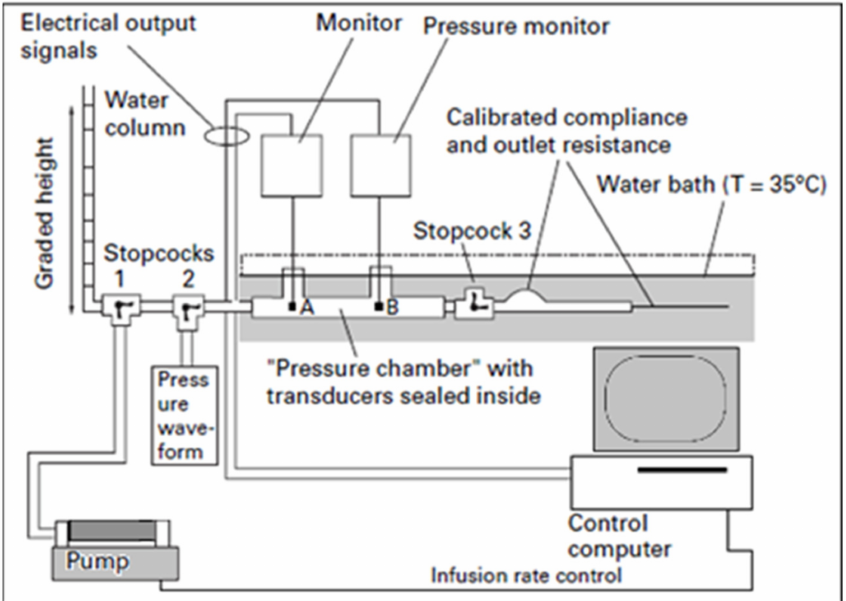
Figure 5. Bench Test Procedure: A bottle is filled with deionised water, leaving 20 mL of air to be removed during dynamic catheter testing. The bottle is then submerged horizontally in a water bath at a constant temperature of 35 ◦ C. Static pressure on the bottle (representing pressure detected by ICP catheters) and reference static pressure (representing true ventricular pressure) are compared by changing the height of a water column in a 1.5 m graded vertical tube. Static pressure is released at intervals by allowing the water to flow out of an opened stopcock; conversely, pressure is increased by infusing fluid into the tubing